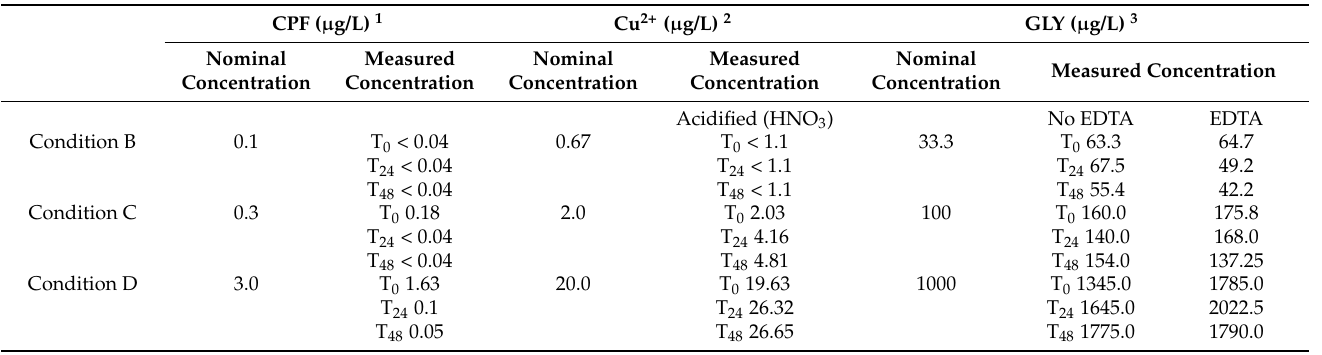
Table 2. Nominal and measured concentrations of chlorpyrifos (CPF), copper (Cu) and glyphosate (GLY) for each condition. Concentrations of samples were analyzed at T 0 , T 24 and T 48